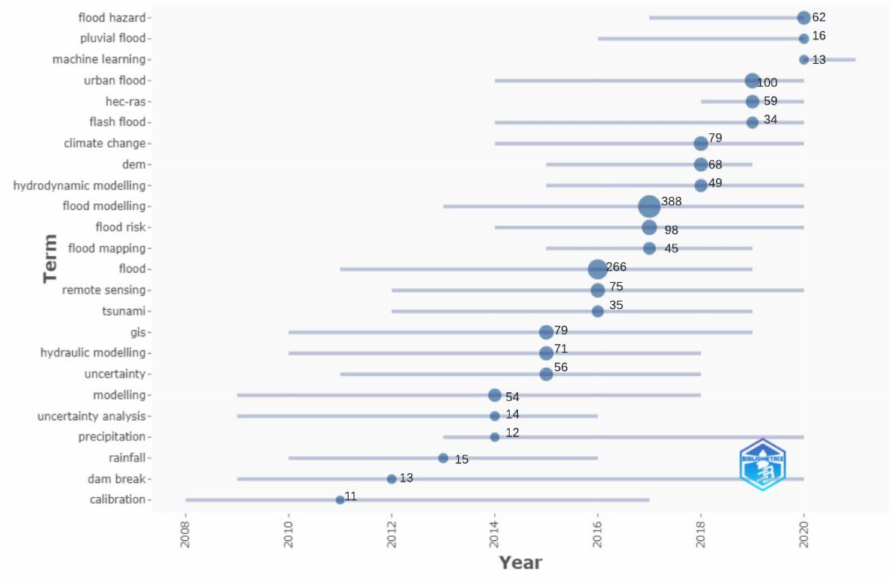
Figure 9. Trend topic of authors’